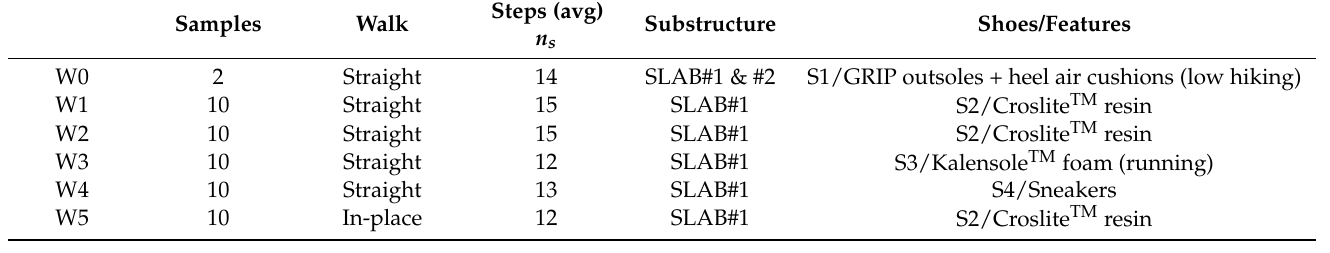
Table 1. Set of walking configurations for experimental acquisitions. SLAB#1 = rigid (laboratory), SLAB#2 = flexible (in-field).